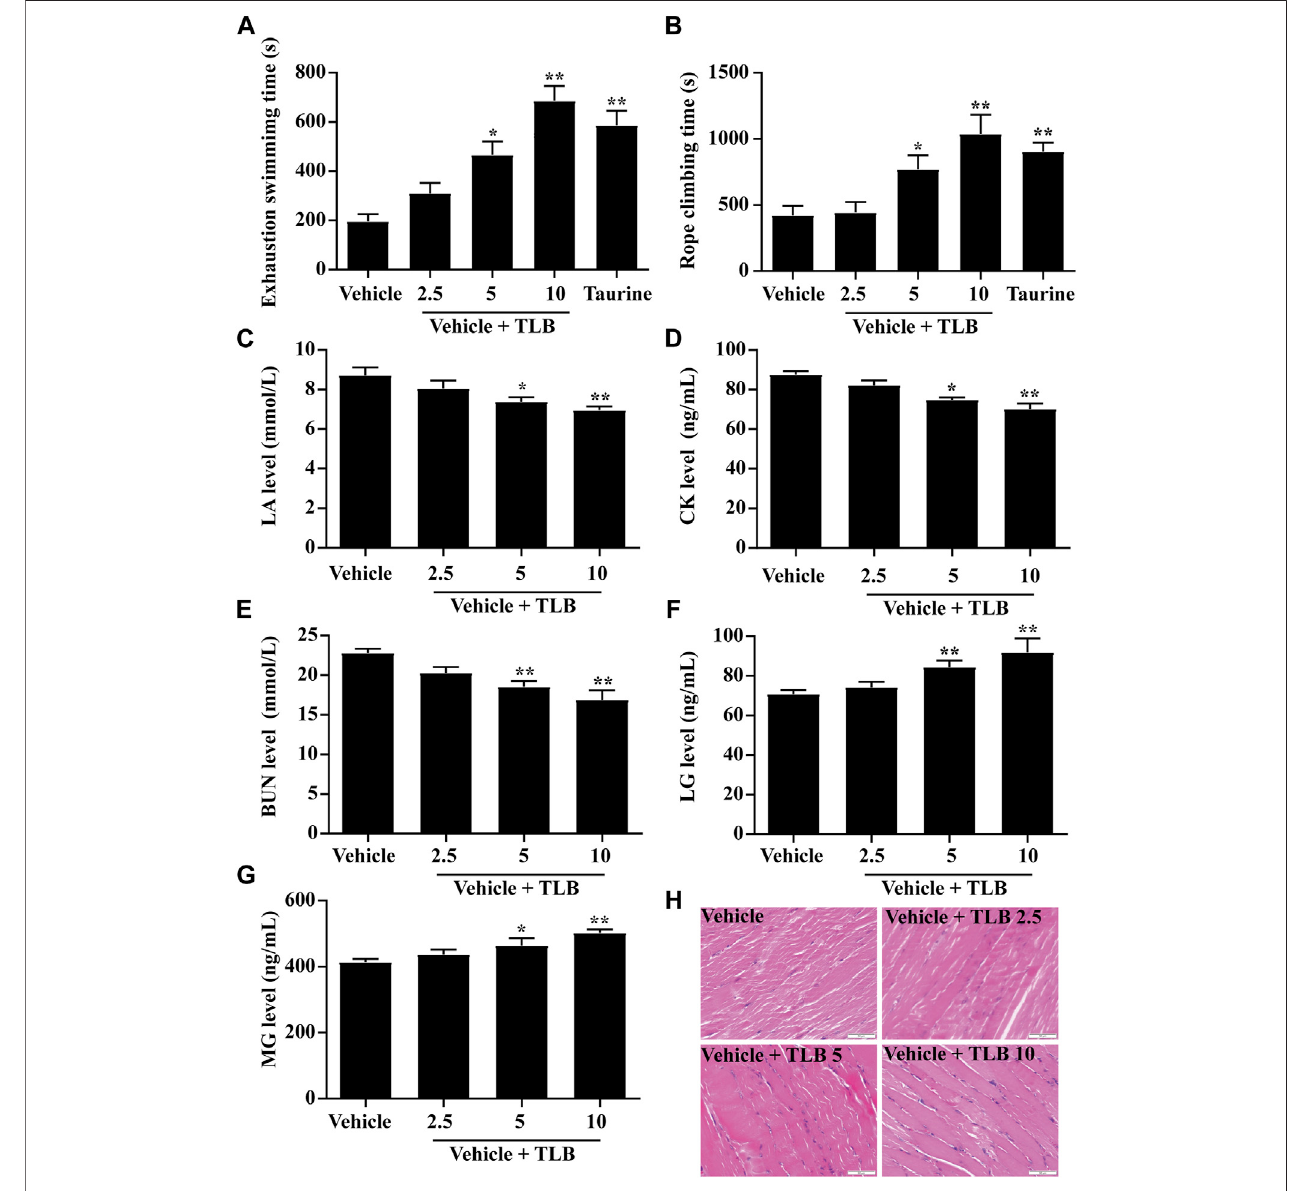
FIGURE 1 | Effect of TLB on EEIF in mice. (A) Exhaustive swimming time ( n = 10), (B) roping fatigue time ( n = 10), (C) LA level (n = 6), (D) CK level ( n = 6), (E) BUN level( n =6), (F) LGlevel( n =6), (G) MG level( n =6),and (H) histological changeofskeletalmuscletissue wasdetermined using HEstaining.Thedatawerepresented as the mean ± SEM. * p < 0.05 and ** p < 0.01 vs vehicle group (magni fi cation ×400 and scale bar = 50 μ m).